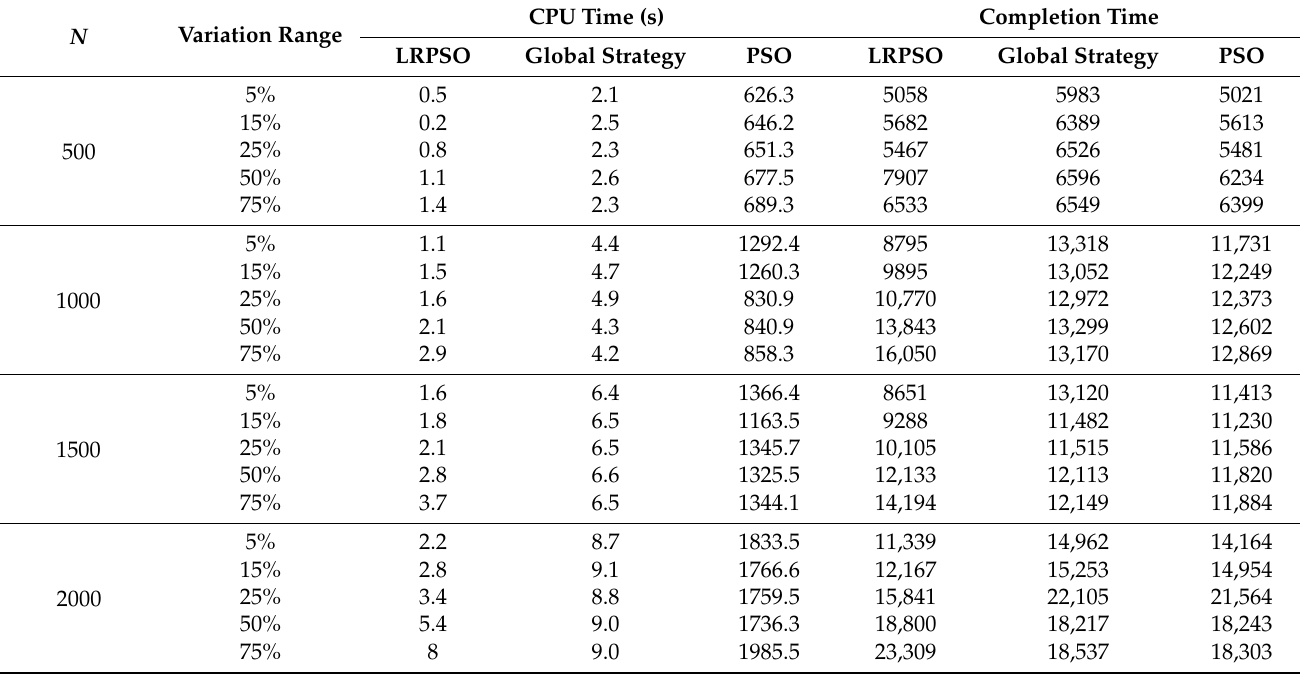
Table 7. Simulation comparison